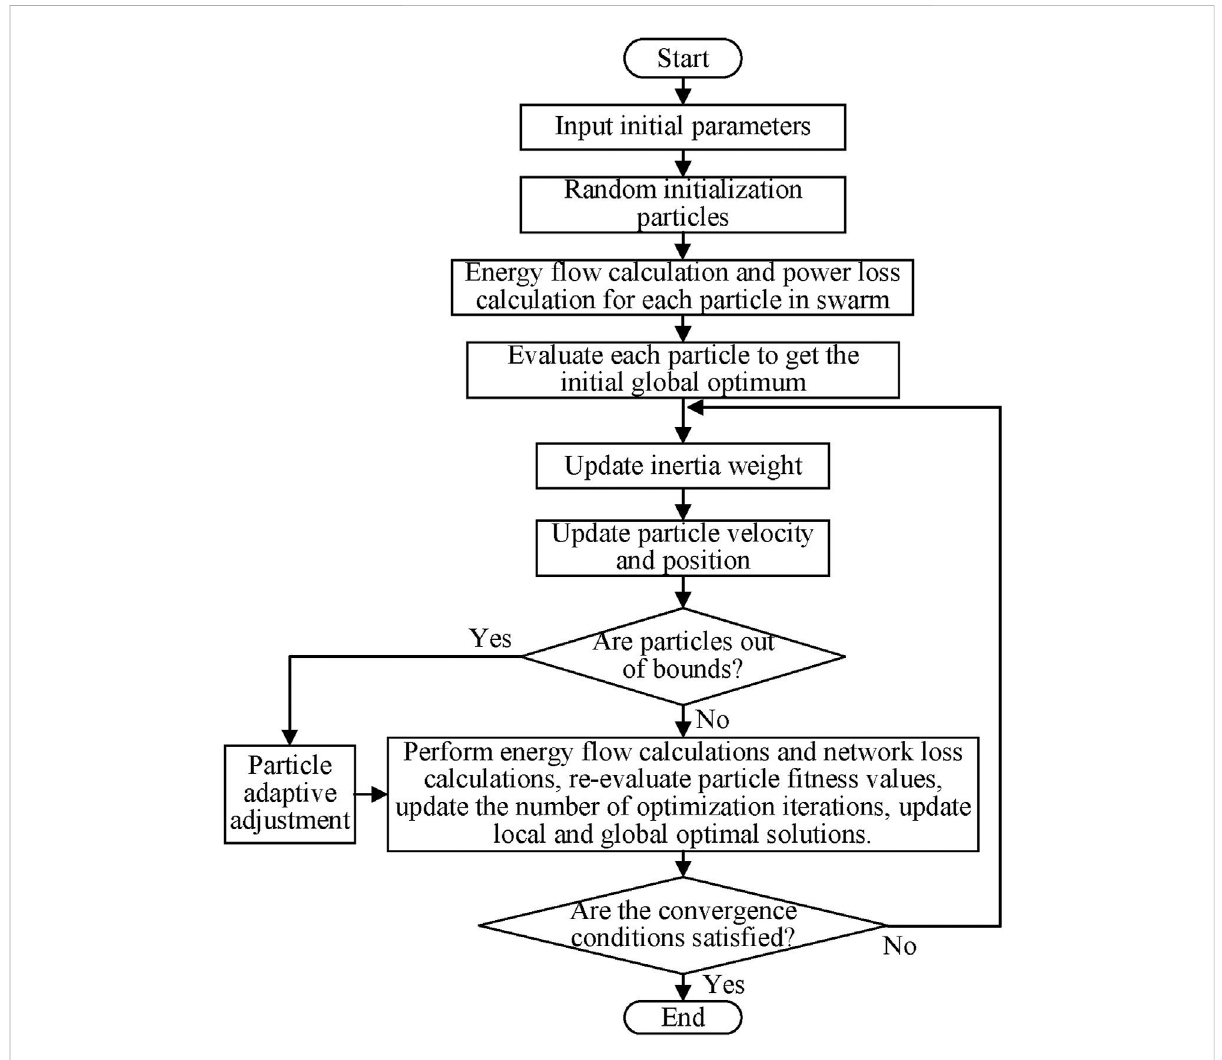
FIGURE 8 The Flow chart of the optimization model